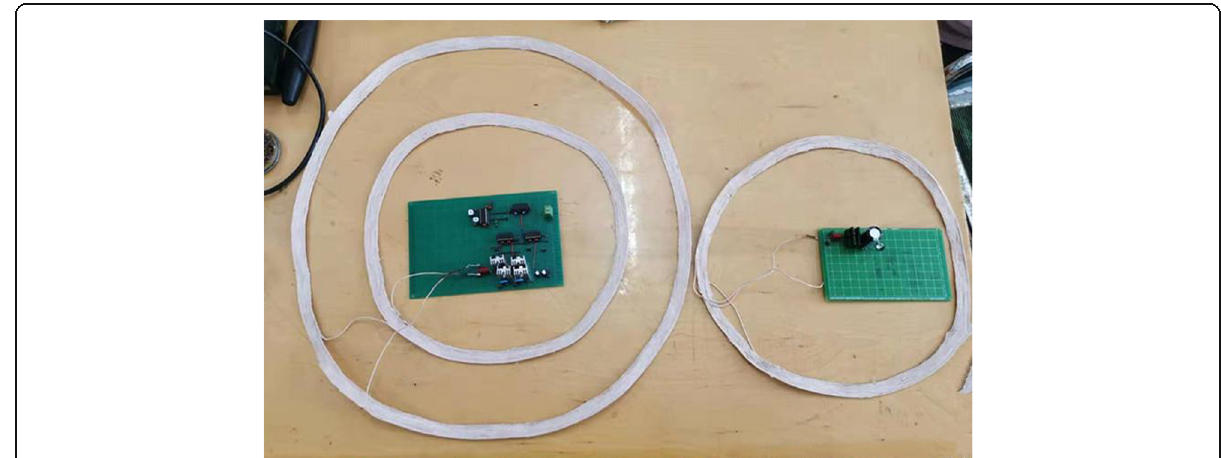
Fig. 11 Asymmetrical coupling coil